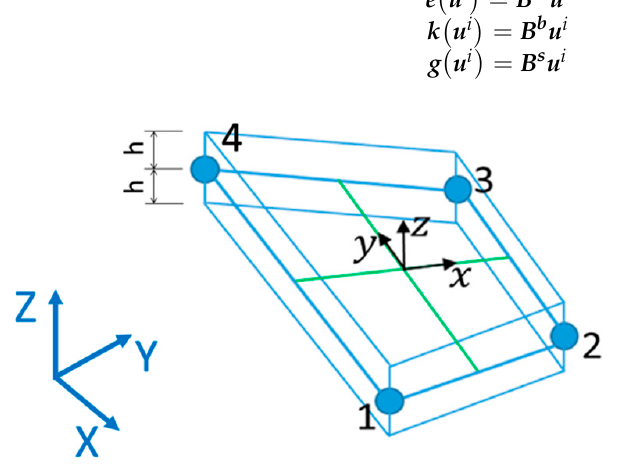
Figure 1. Local (x, y, z) and global (X, Y, Z) reference systems for the iQS4 element; numbers 1 to 4 represent the local node labels.